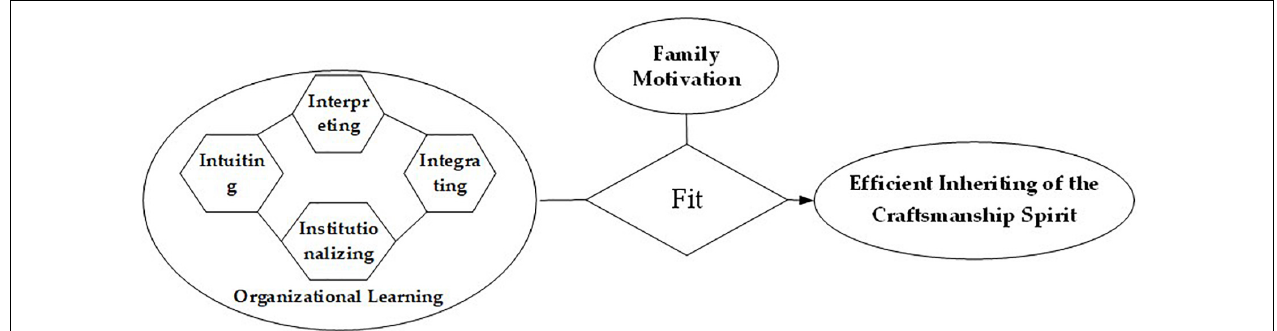
FIGURE 1 | Conceptual